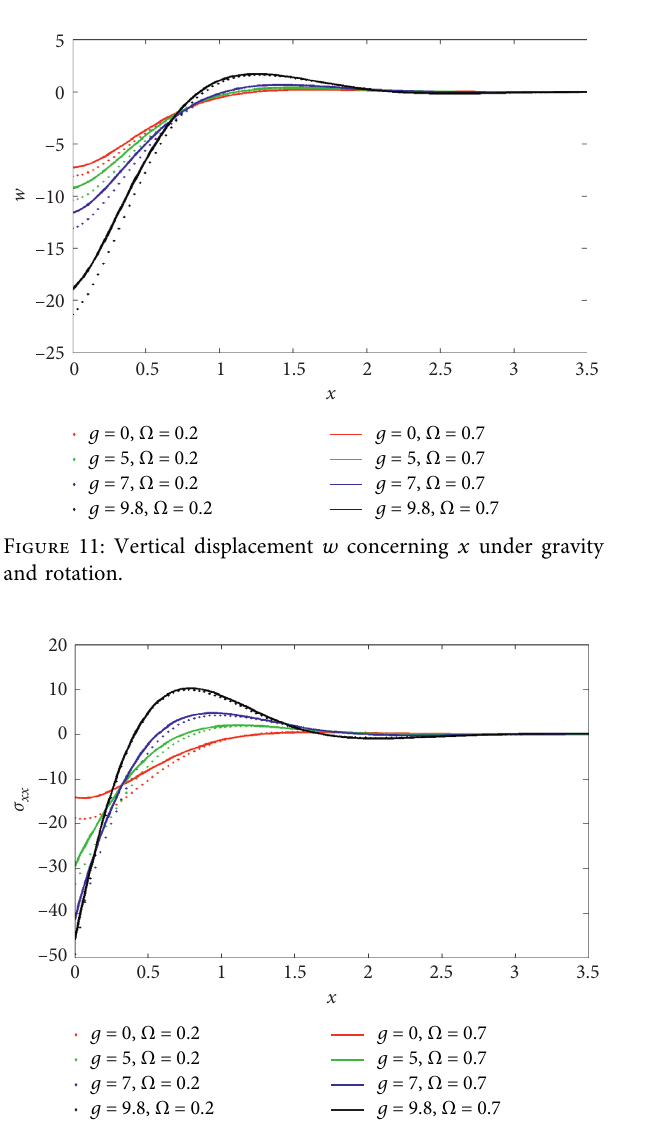
Figure 12: Stress σ x under gravity and rotation. xx concerning